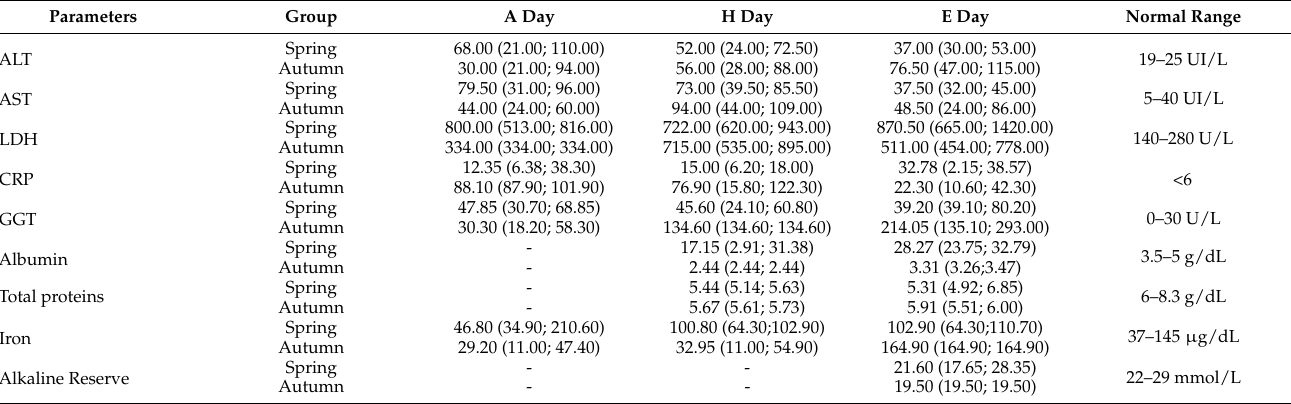
Table 8. Abnormal and normal biochemical blood values in the two groups on three specific days in the ICU—Brixia A, H and E: median values and interquartile